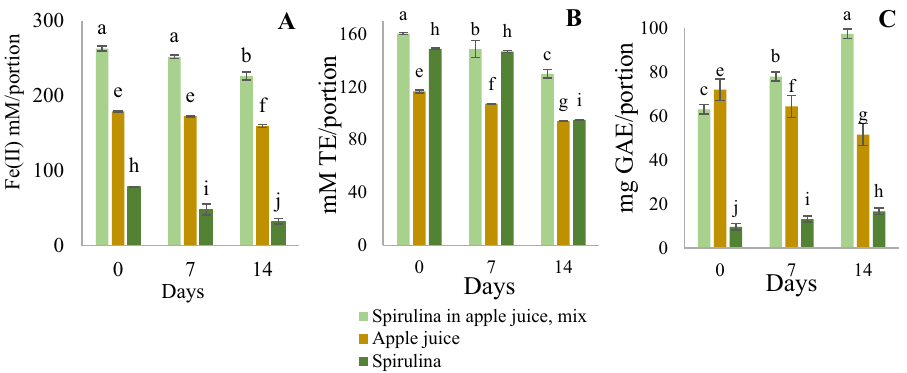
Figure 2. Reducing power ( A ), antioxidant activity ( B ) and polyphenol content ( C ) change with time of spirulina, apple juice, and a mixture of both at + 2… + 8 °C. The different letters for each product measurements represent significant differences at p < 0.05.